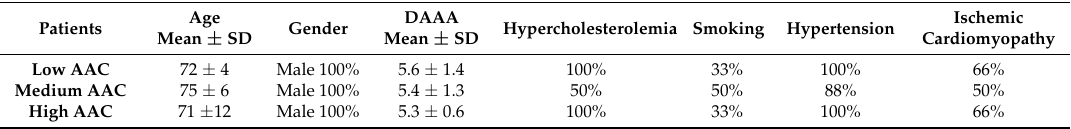
Table 3. Demographical and clinical feature of AAA patients. It shows demographical data (age, sex) and cardiovascular risk (DAAA aneurysm diameters, hypercholesterolemia, smoking, hypertension, and ischemic cardiomyopathy). Age and DAAA are represented as mean ± standard deviation. Patient data are divided by the grade of aortic calcification index